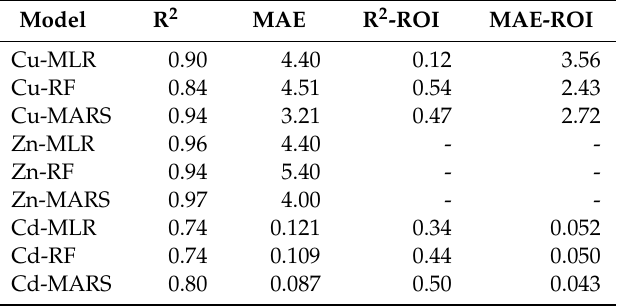
Table 5. Validation statistics from the farm dataset of the multiple linear regression (MLR), random forest regression (RF), and multivariate adaptive regression spline (MARS) models for copper (Cu), zinc (Zn), and cadmium (Cd). R 2 = coe ffi cient of determination; MAE = mean absolute error (mg kg − 1